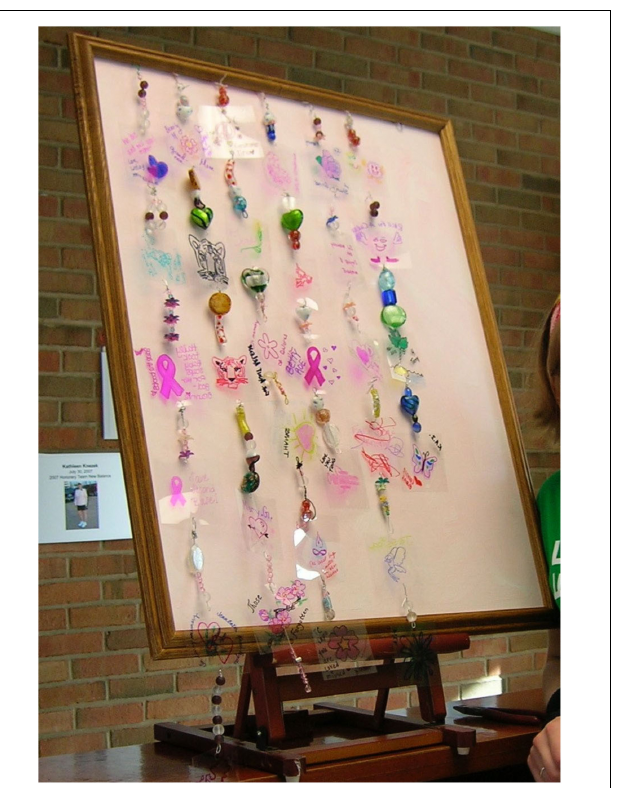
FIGURE 6 | A view of the soup kitchen’s art room and peace tree.